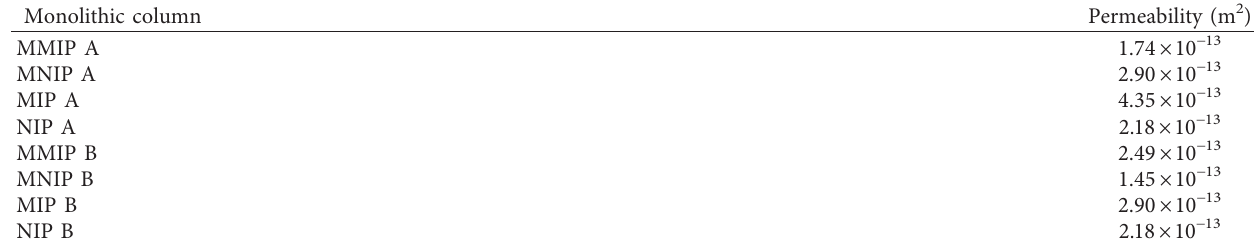
Table 3: Column permeability of MMIP, MNIP, MIP, and NIP monoliths.